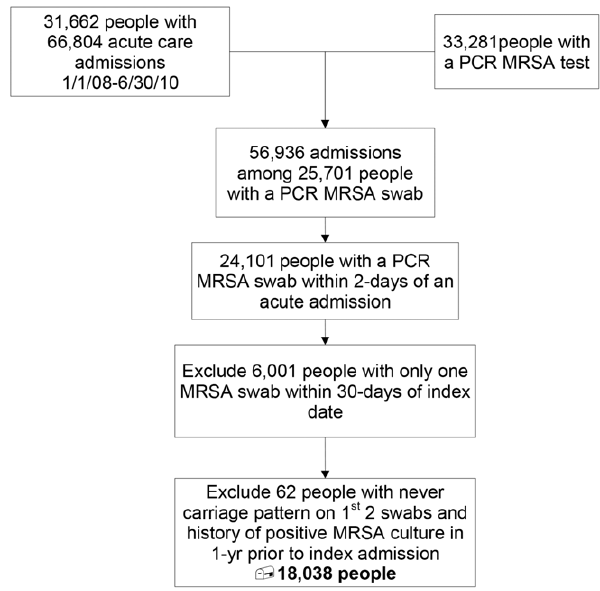
Figure 1. Flow Diagram. Derivation of the study cohort.